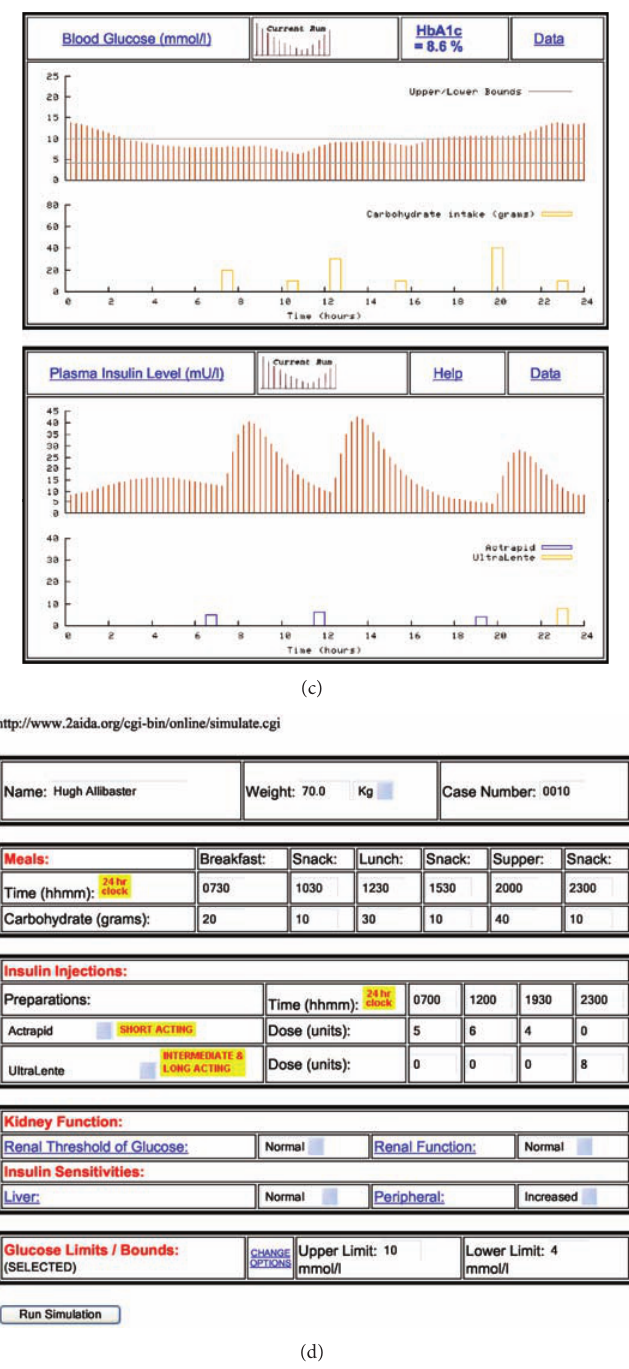
Figure 4: (a) AIDA online 2 options.htm Case Selector screen showing Case Scenario 0010 highlighted. Options to select the “Blood Glucose Units” and “Standard” versus “Advanced (includes fluxes)” display are shown lower down the page. (b) AIDA online 2 dynamically-generated HTML web page, produced by intro.cgi Perl script, populated with information and data for case scenario number 0010 (Hugh Allibaster). Clicking on the (Run Simulation) button at the bottom of the web page will submit the data shown to the simulate.cgi script to run the simulation engine and generate a graphical simulation (as shown in Figure 4(c)). (c) Baseline simulation using AIDA online 2 with data shown in Figure 4(b) for Hugh Allibaster (case scenario 0010). Top panel: Blood glucose (BG) level and carbohydrate intake over a 24 hour period. User definable normoglycaemic ranges (“Upper/Lower Bounds”: 4–10mmol/L [72–180 mg/dL]) are shown superimposed. Lower panel: Plasma insulin level and injections of Actrapid (short-acting) and UltraLente (long-acting) insulins. The HbA indication—for educational purposes—of the glycosylated haemoglobin level predicted by the AIDA model, if the current glycaemic control were to be maintained in the medium- to long-term. (d) Scrolling down the simulate.cgi page shown in Figure 4(c) yields a dynamically- generated HTML data entry form populated with the data used for the simulation, which—for a baseline (initial) simulation—will be identical to that shown in Figure 4(b). The user can now change any of the data values and run a further simulation by clicking on the (Run Simulation) button at the bottom of the